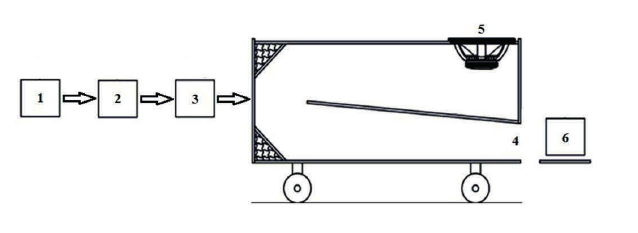
Fig. 1. Elements of the high- power acoustic extinguisher: 1 – generator; 2 – modulator; 3 – power amplifier; 4 – output; 5 – sound source; 6 – flame source. Information on the identification of a technogenic emergency in the acoustic radiation of a hazard zone [26] and the development of a model of the burning substance in the burning seat [27 ], as well as acoustic methods was presented in the works of Ukrainian scientists [28]– [30]. The effectiveness of acoustic waves depends on the level of pressure turb ulence to disrupt the flame front, extend it, and extinguish it [25], [31]–[33]. This is the result of the extension affects its aerodynamic distortion [34]. The deviation of one of the